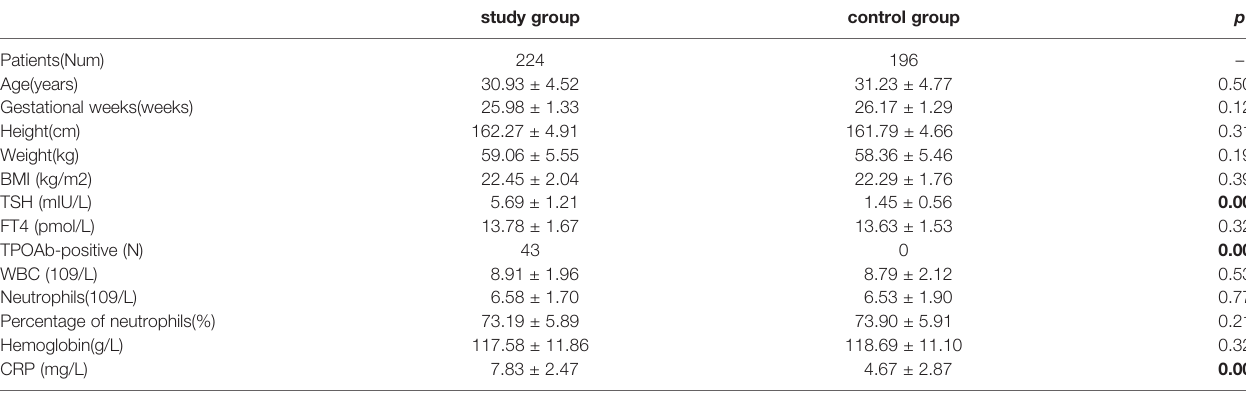
Boldface indicates statistical signi fi cance. TABLE 2 | The rate of SIBO-positive, pure Hydrogen-positive, pure Methane-positive and Hydrogen-Methane positive between Pregnant women with subclinical hypothyroidism (study group) and the control group (control group).